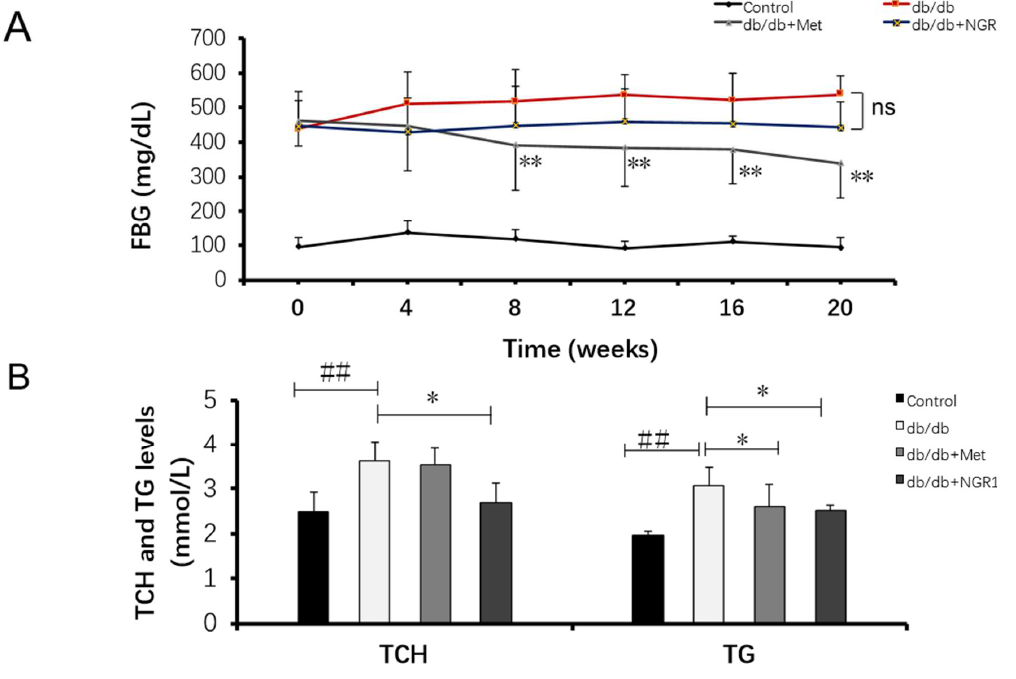
Figure 2. The impact of NGR1 on fasting blood glucose (FBG), total cholesterol (TCH), and triacylglycerol (TG) levels in db / db mice. ( A ) Fasting blood glucose level in db / db mice with NGR1 and metformin treatment; ( B ) total cholesterol (TCH) and triglyceride (TG) levels in db / db mice with NGR1 and metformin treatment. All data are presented as the mean ± SD ( n = 8). ## p < 0.01 vs. the control group; * p < 0.05 vs. the model group.